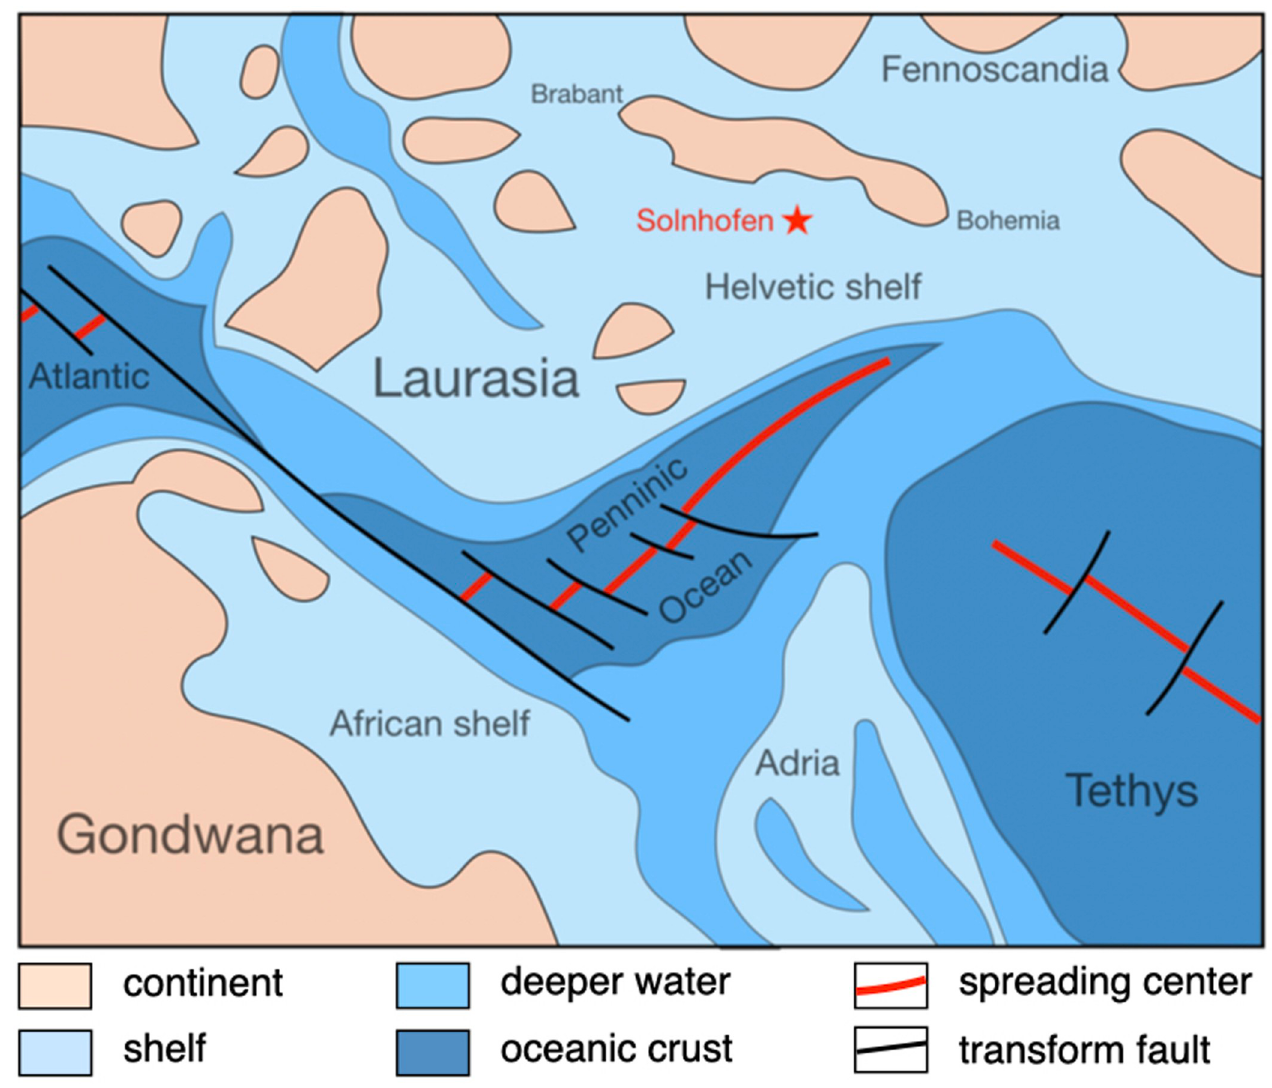
Fig 3. Palaeogeography around the Helvetic shelf in the Upper Jurassic. Modified from Schuster et al. [30].